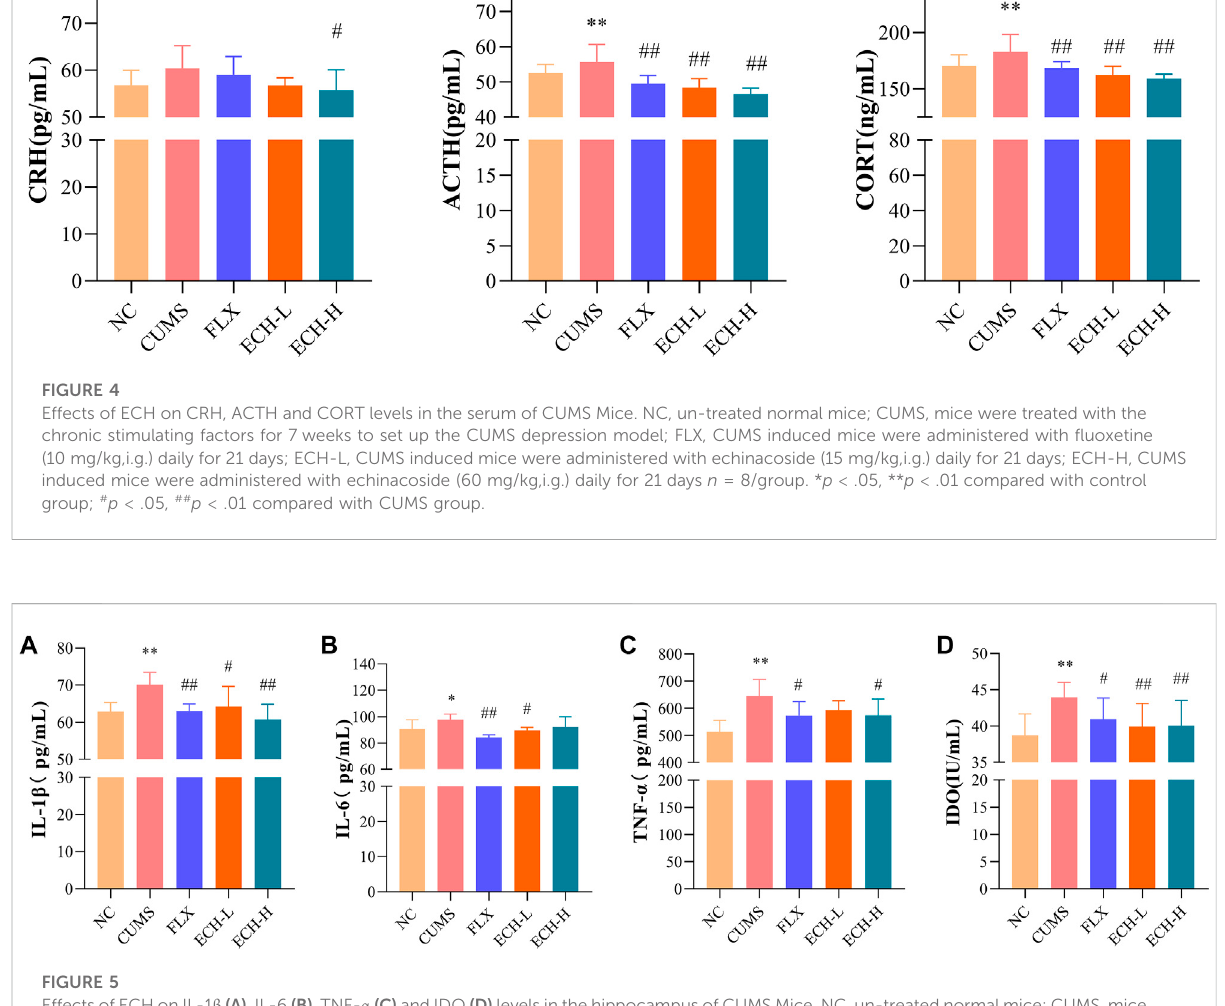
Effects of ECHon IL-1 β (A) , IL-6 (B) ,TNF- α (C) and IDO (D) levels in thehippocampus ofCUMS Mice. NC, un-treated normal mice; CUMS,mice were treated with the chronic stimulating factors for 7 weeks to set up the CUMS depression model; FLX, CUMS induced mice were administered with fl uoxetine (10 mg/kg,i.g.) daily for 21 days; ECH-L, CUMS induced mice were administered with echinacoside (15 mg/kg,i.g.) daily for 21 days; ECH-H, CUMS induced mice were administered with echinacoside (60 mg/kg,i.g.) daily for 21 days. n = 6/group. * p < .05, ** p < .01 compared with control group; # p < .05, ## p < .01 compared with CUMS